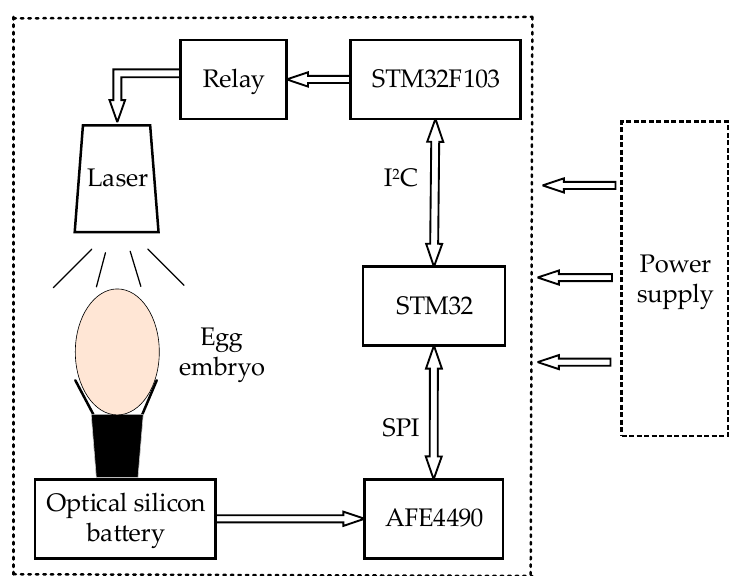
Figure 1. Data acquisition device schematic. The system acquisition terminal uses the AFE(Active Front End)4490 chip, which is a fully integrated analog front end designed by Texas Instruments for clinically required arterial oxygen saturation measurements. The control terminal selects the STM(STMicroelectronics)32 microcontroller. The sensor uses a photo-silicon cell with a large photosensitive area, high sensitivity, and wide sensitivity range. The laser source uses a near-infrared source of 808 nm [19].